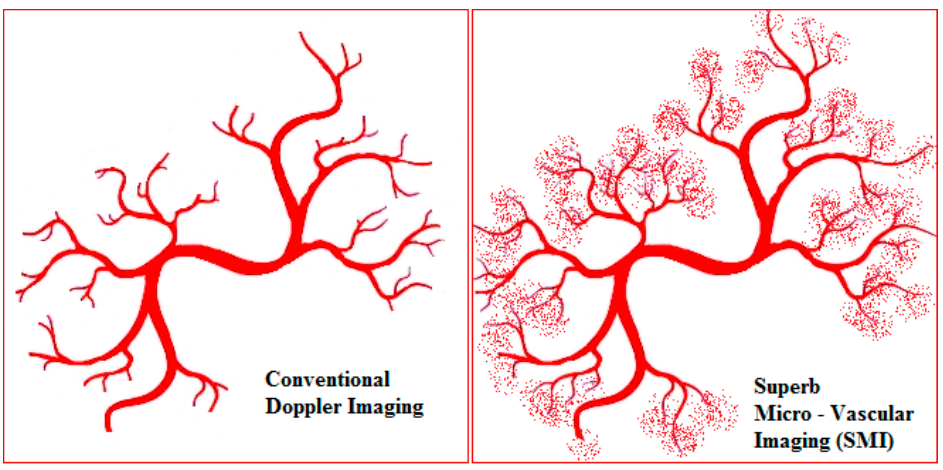
Figure 1. The schematic view of the difference between power Doppler and superb microvascular imaging (SMI) in the evaluation of small low-flow vessels.